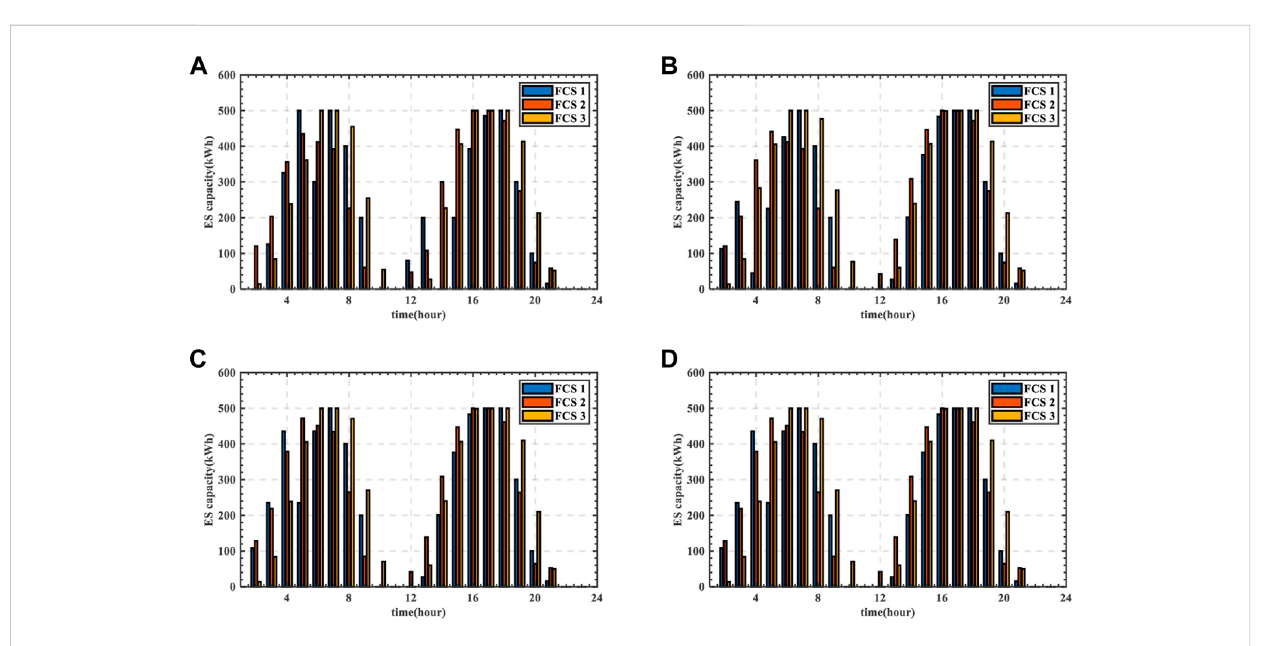
FIGURE 16 ES operation status of scenario 4 for the shortest